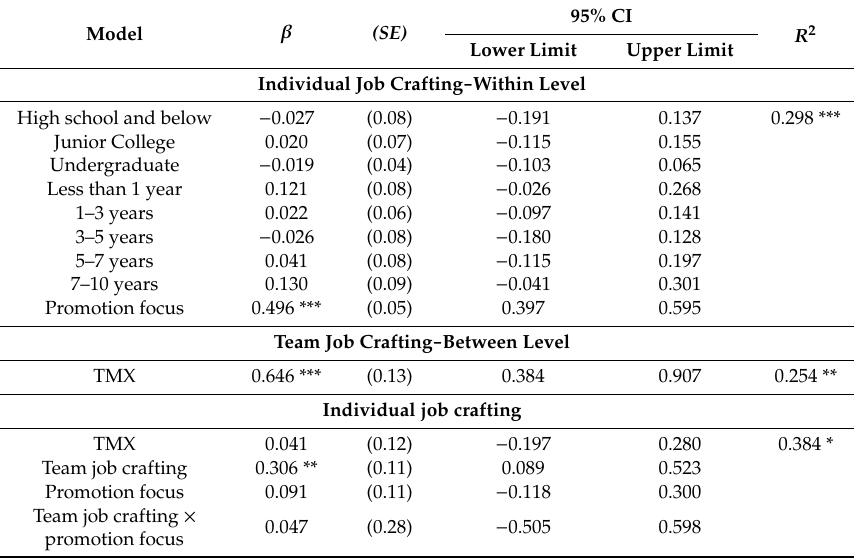
Table 10. Moderated mediation of promotion regulatory focus.